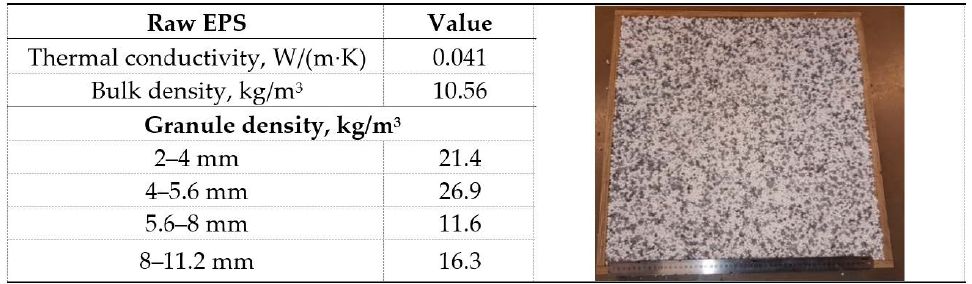
Figure 6. Physical properties of EPS granules and bulk EPS prepared for thermal conductivity test.